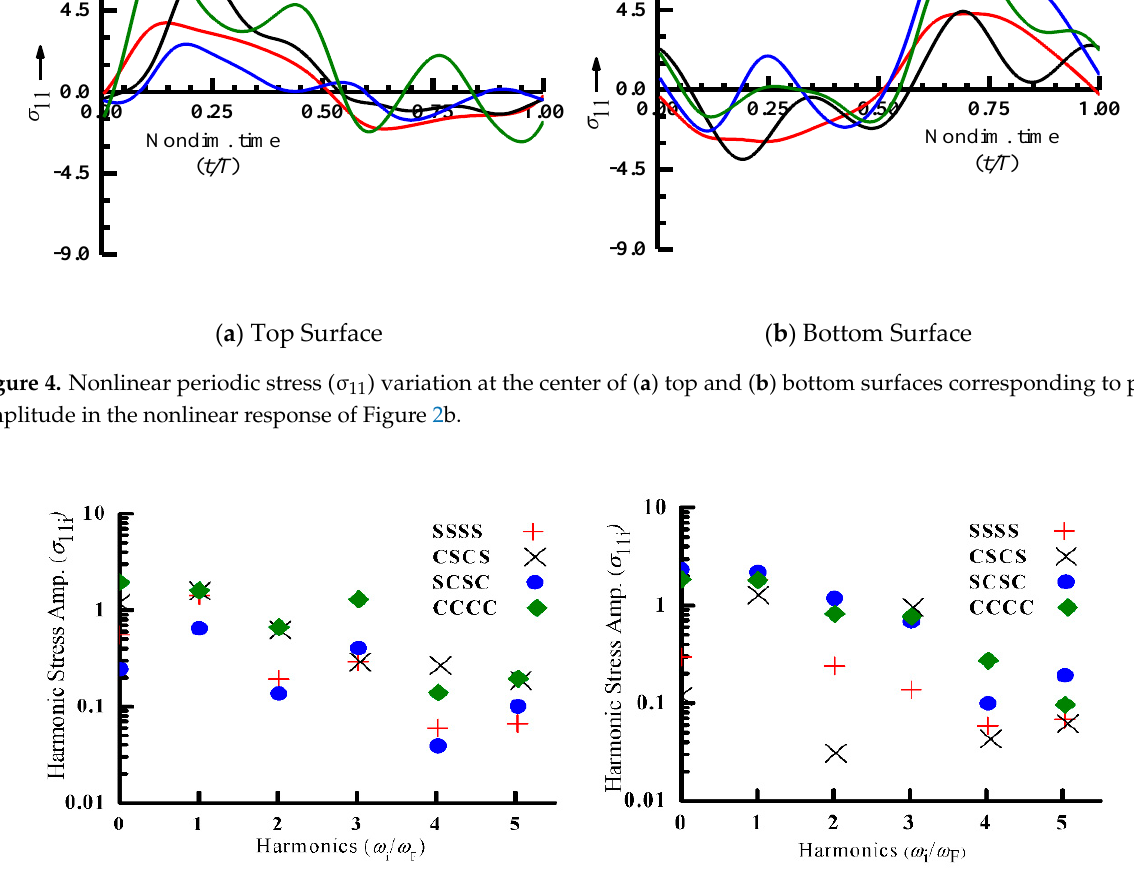
11 ) corresponding to Figure 4.